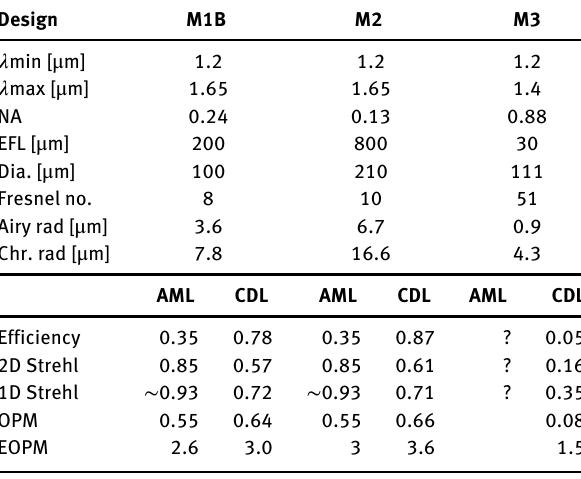
Table 1: Comparison of achromatic metalenses (AMLs) of [5] to equivalent conventional diffractive lenses